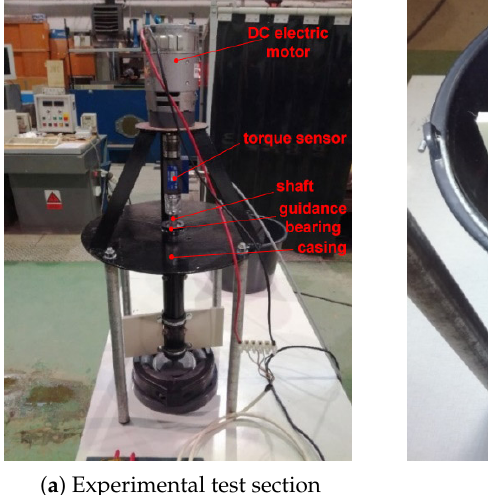
Figure 3. Experimental